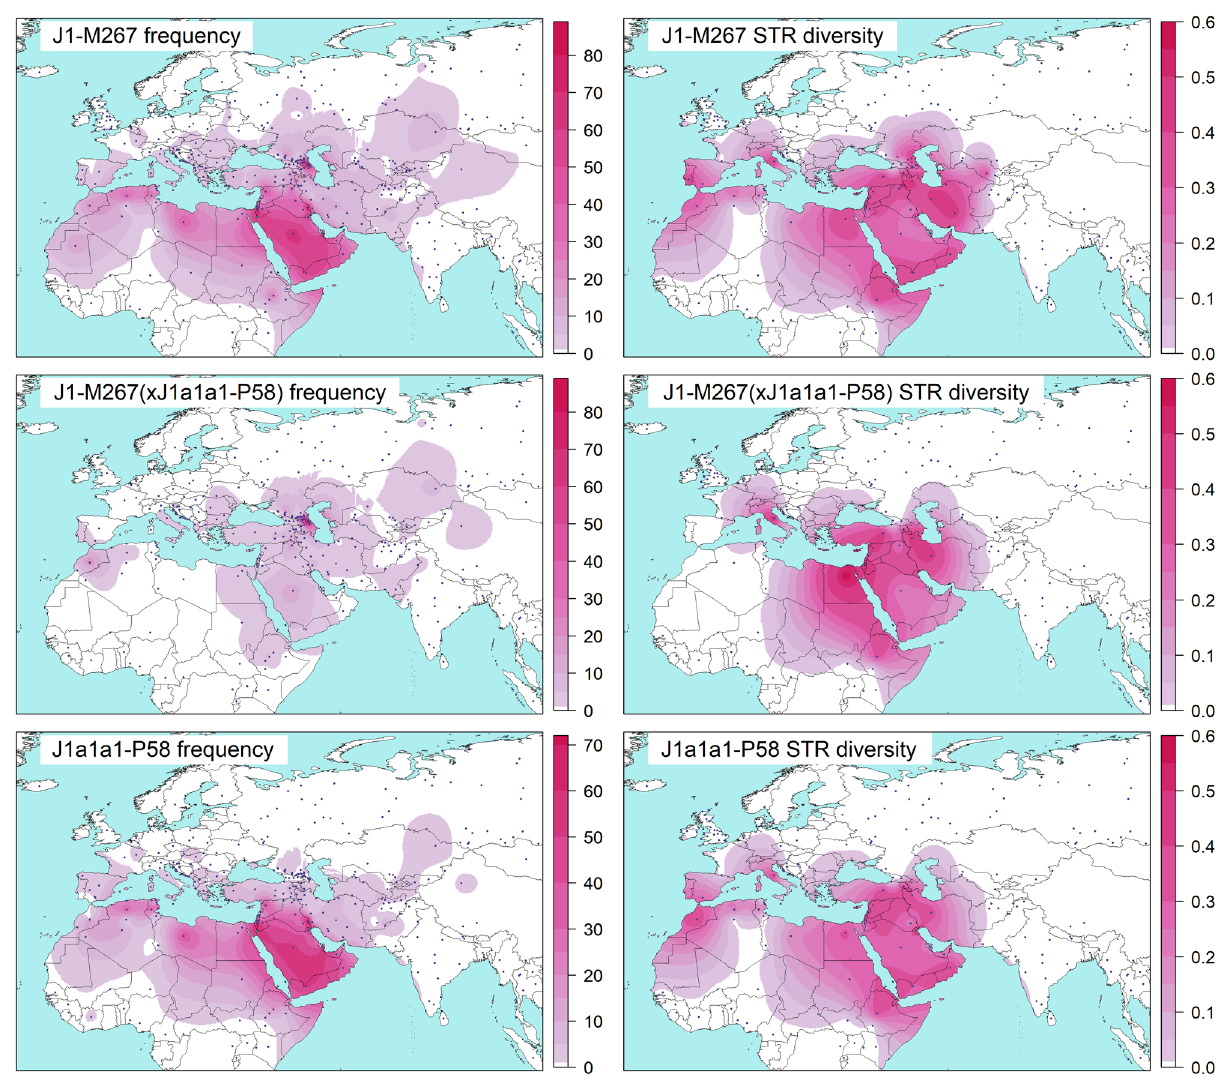
Figure 1. Spatial frequency and diversity distribution maps. Datasets for the frequency plots differ. Please note the difference in the scales. Data from Supplementary Table S7 are used to generate the frequency maps. The diversities were calculated with 8 short tandem repeats (STR) reported in Supplementary Table S8. Blue filled circles mark sampling locations. Maps were generated in RStudio software v1.2.5019 based on R